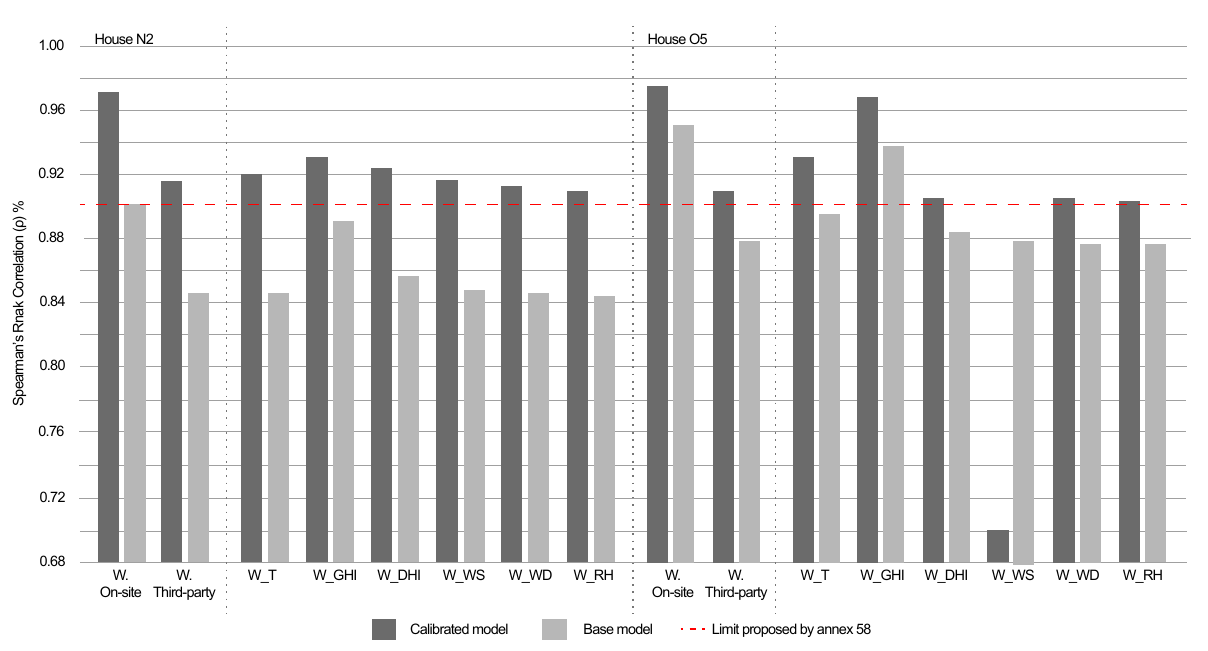
Figure 9. Results of the ρ index of the base and calibrated models with the different weather files created. Training period, Houses N2 and O5.